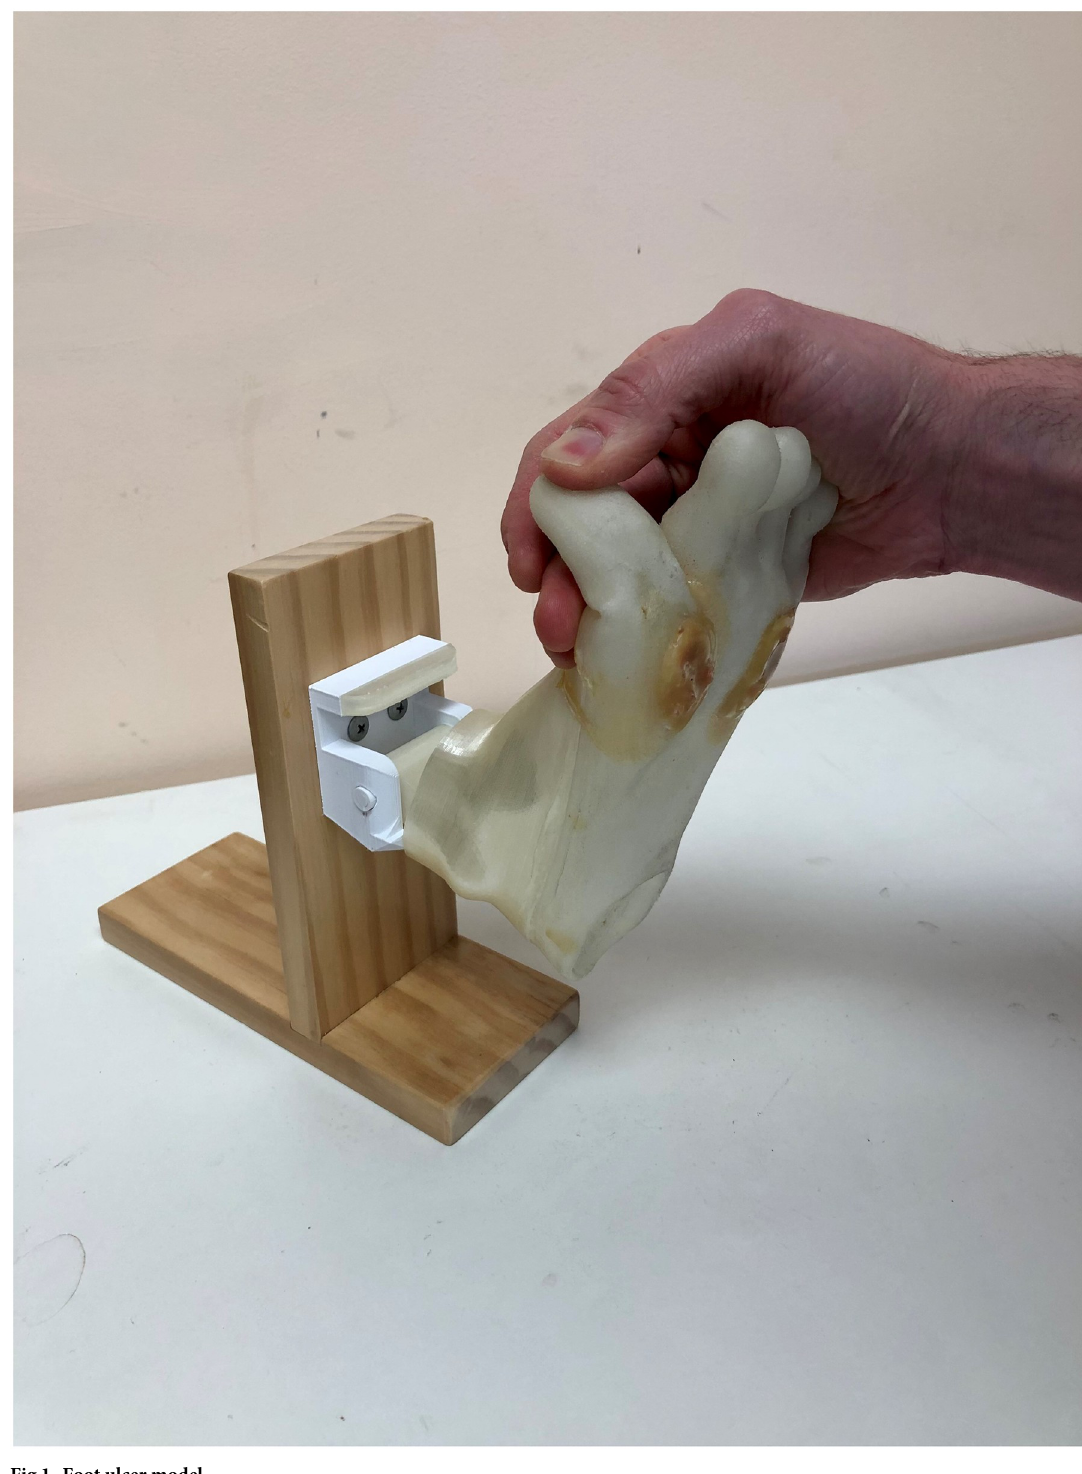
Fig 1. Foot ulcer